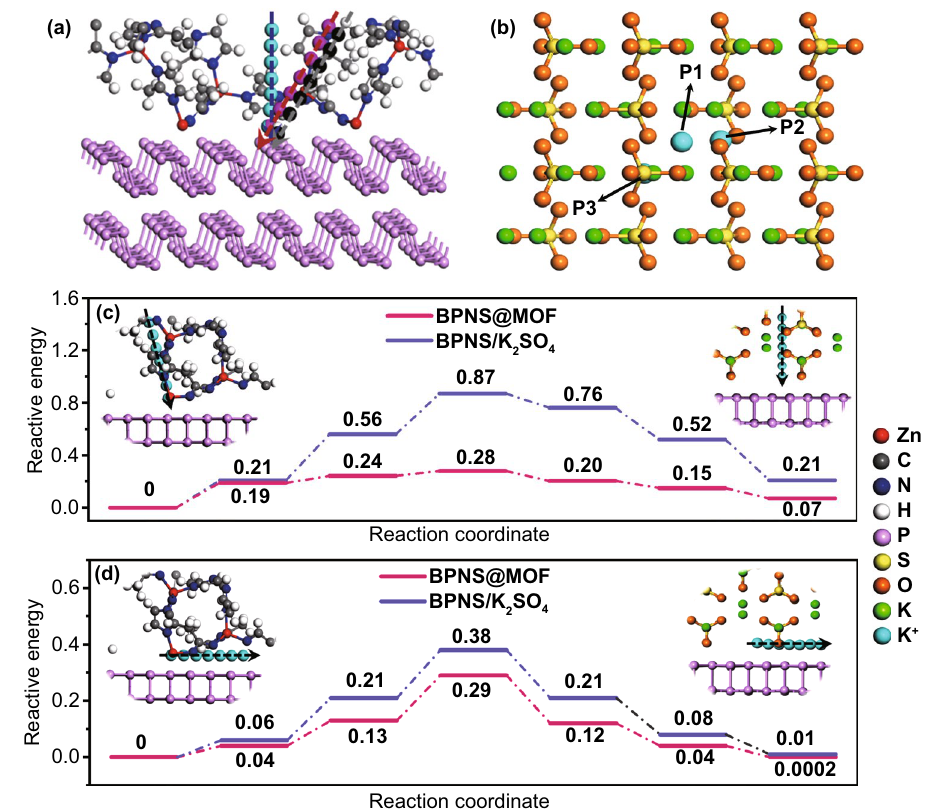
Fig. 6 Theoretical analysis of reaction kinetics. a Different pathways when K ions pass through MOF in the model of BP(020)-MOF(112). b Different sites of K ions in the model of BP(020)-K 2 SO 4 (002). (BPNS is neglected in order to exhibit the site clearly). c Diffusion energy profile for potassium diffusion through the MOF and K 2 SO 4 . Inset of c is the side views of the diffusion pathways. d Diffusion energy profile for potas- sium over the surface of BP. Inset of d is the side views of the diffusion pathways. Inset of both c and d shows ab